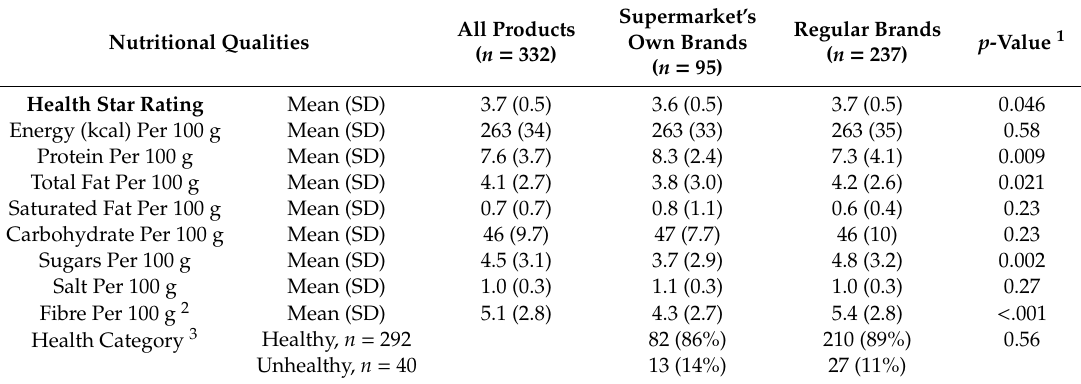
Table 1. Nutritional qualities of di ff erent bread products in Swedish supermarkets divided in supermarket own brand products and regular